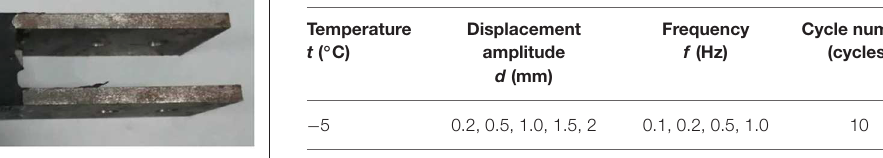
TABLE 1 | Loading conditions for properties tests of the viscoelastic